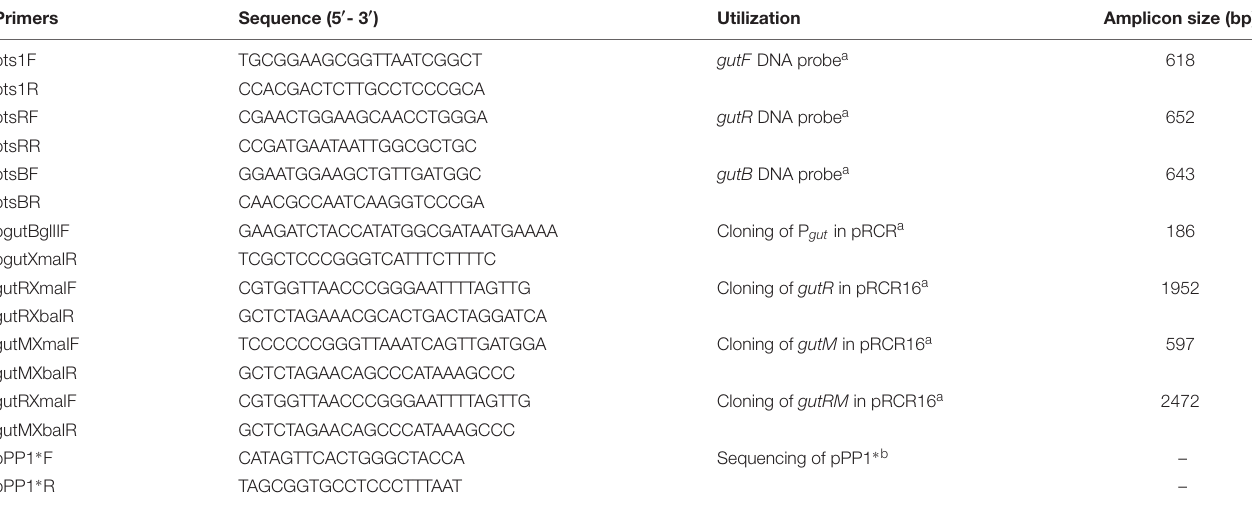
TABLE 2 | Oligonucleotides used in this